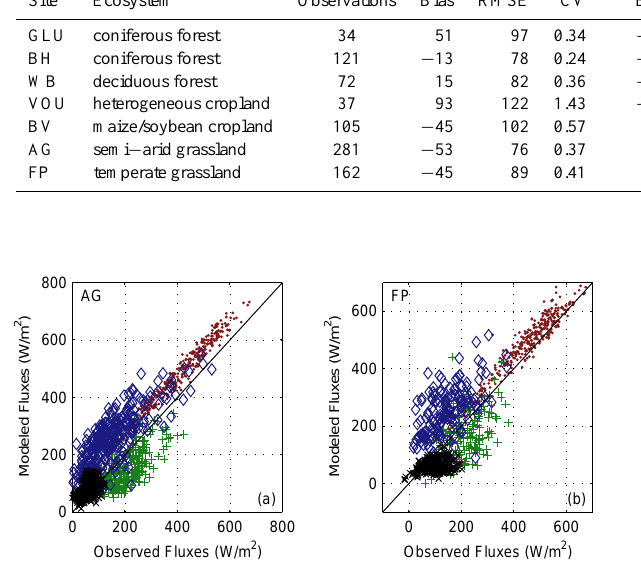
Fig. 9. Instantaneous modelled net radiation (points), latent heat (diamonds), sensible heat (crosses) and ground heat (x-es) fluxes at grassland sites: AG semi-arid (a) and FP temperate (b) . DTD was run using predominantly MODIS inputs with f g estimated using VI and night time fluxes ignored.